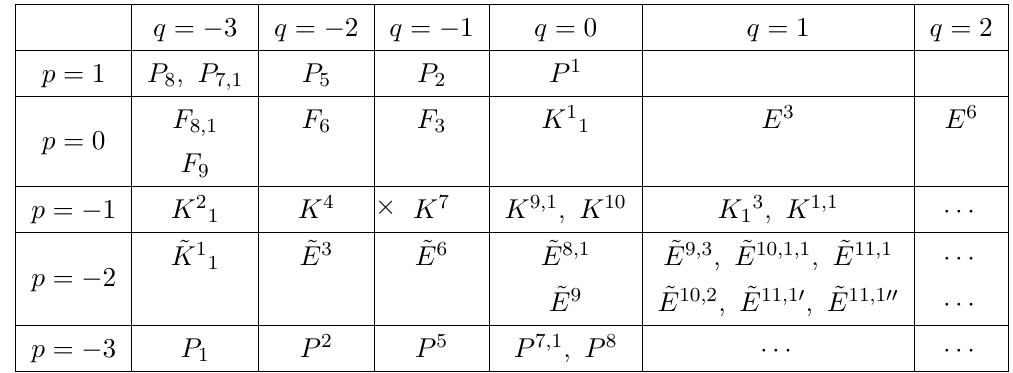
Table 2 . Part of the tensor hierarchy algebra T in gl (11) level decomposition. p denotes the gen- eral Z -grading of the tensor hierarchy algebra and the additional grading q is related to the gl (11) level ‘ by ‘ = q (cid:0) 3 p . The usefulness of q is that the involution of T acts on ( p; q ) by sending it to 2 ( (cid:0) 2 (cid:0) p; (cid:0) 3 (cid:0) q ) and can be represented in this table by a point reflection about the place marked with a cross. The involution includes mapping gl (11) representations to their duals and for p < 0 we have explicitly dualised all representations. For p = 0 we have explicitly separated T 0 into e 11 and the ad- ditional generators from the tensor hierarchy algebra extension. The additional generators are given in the second line. Since T (cid:0) 2 (cid:24) = T (cid:3) , we have performed the same line split for p = (cid:0) 2 . The fields 0 appear at p = (cid:0) 2 and we see explicitly the first additional generator ~ E 9 at ( (cid:0) 2 ; 0) that is